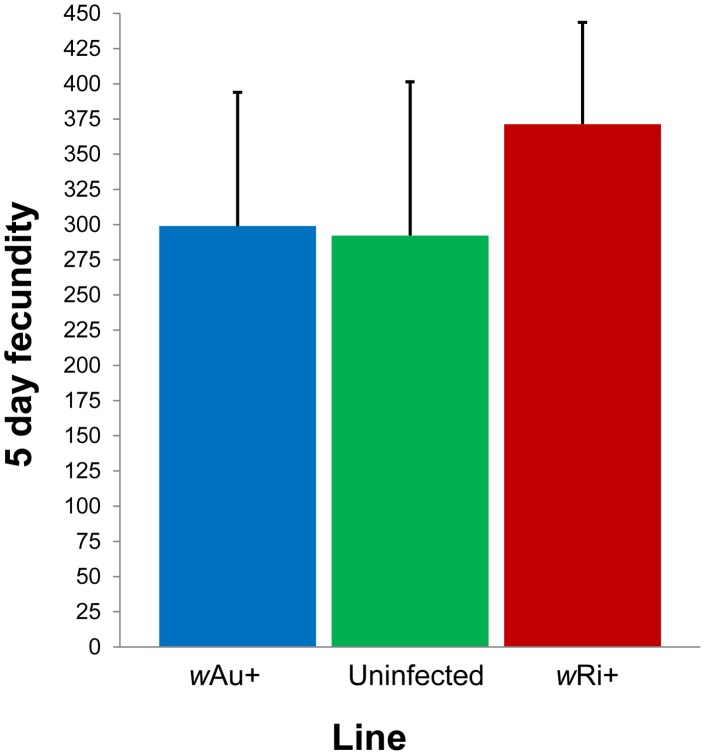
Fecundity assays on Australian wRi-infected, wAu-infected, and uninfected laboratory lines of D. simulans.Mean number of eggs laid over 5 d by wRi-infected (red bar), uninfected (green bar) and wAu-infected (blue bar) females. Error bars are standard errors.